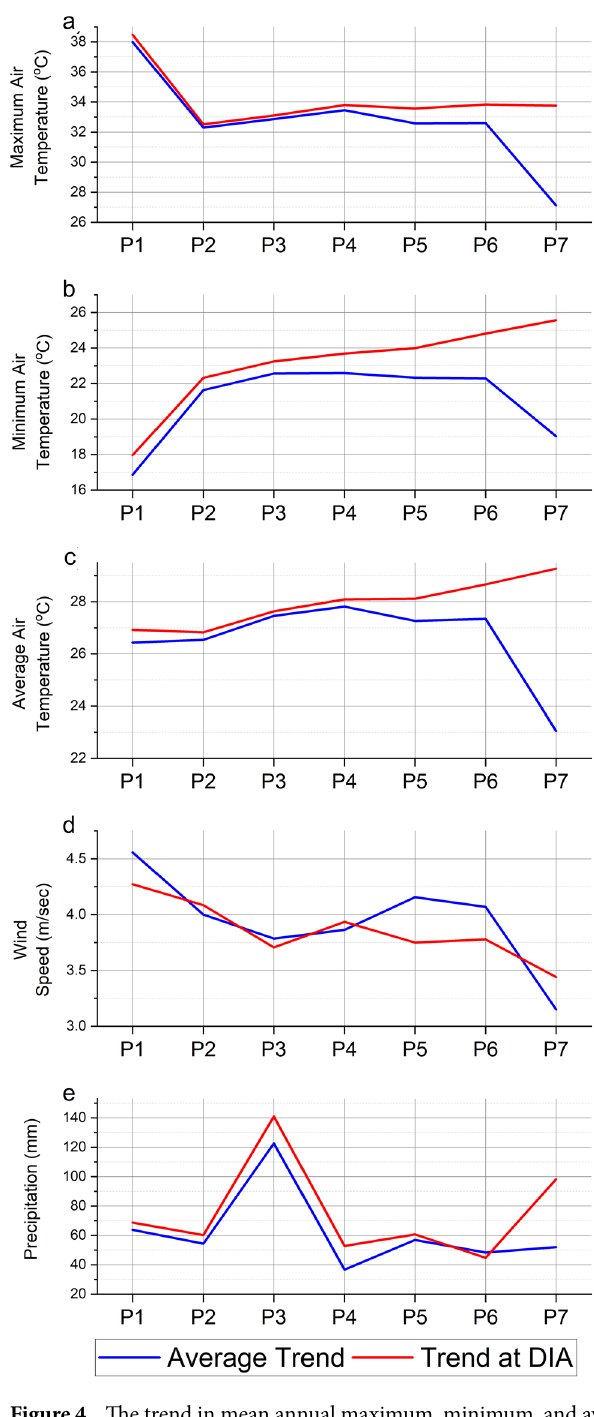
Figure 4. The trend in mean annual maximum, minimum, and average air temperatures, wind speed, and precipitation during the studied periods averaged over Qatar (blue lines) and at Doha International Airport station (red